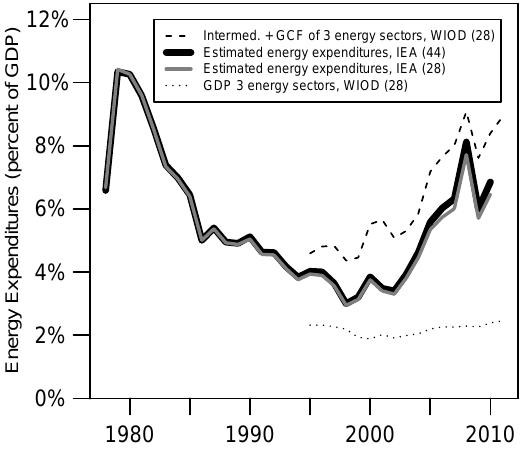
Figure 5. A comparison of expenditures on energy relative to total GDP for the world shows that the calculation in this paper most closely matches intermediate expenditures in the three energy sectors of the WIOD rather than the portion of GDP associated with those three energy sectors. “Intermed” = intermediate spending of the three energy sectors, and “GDP 3 energy sectors” = the portion of GDP for the three energy sectors. WIOD = uses data in World Input Output Database; IEA = uses IEA data as calculated in this manuscript; 44 = calculations include data from all 44 countries in our IEA dataset; and 28 = calculations include only 28 countries in both WIOD and IEA